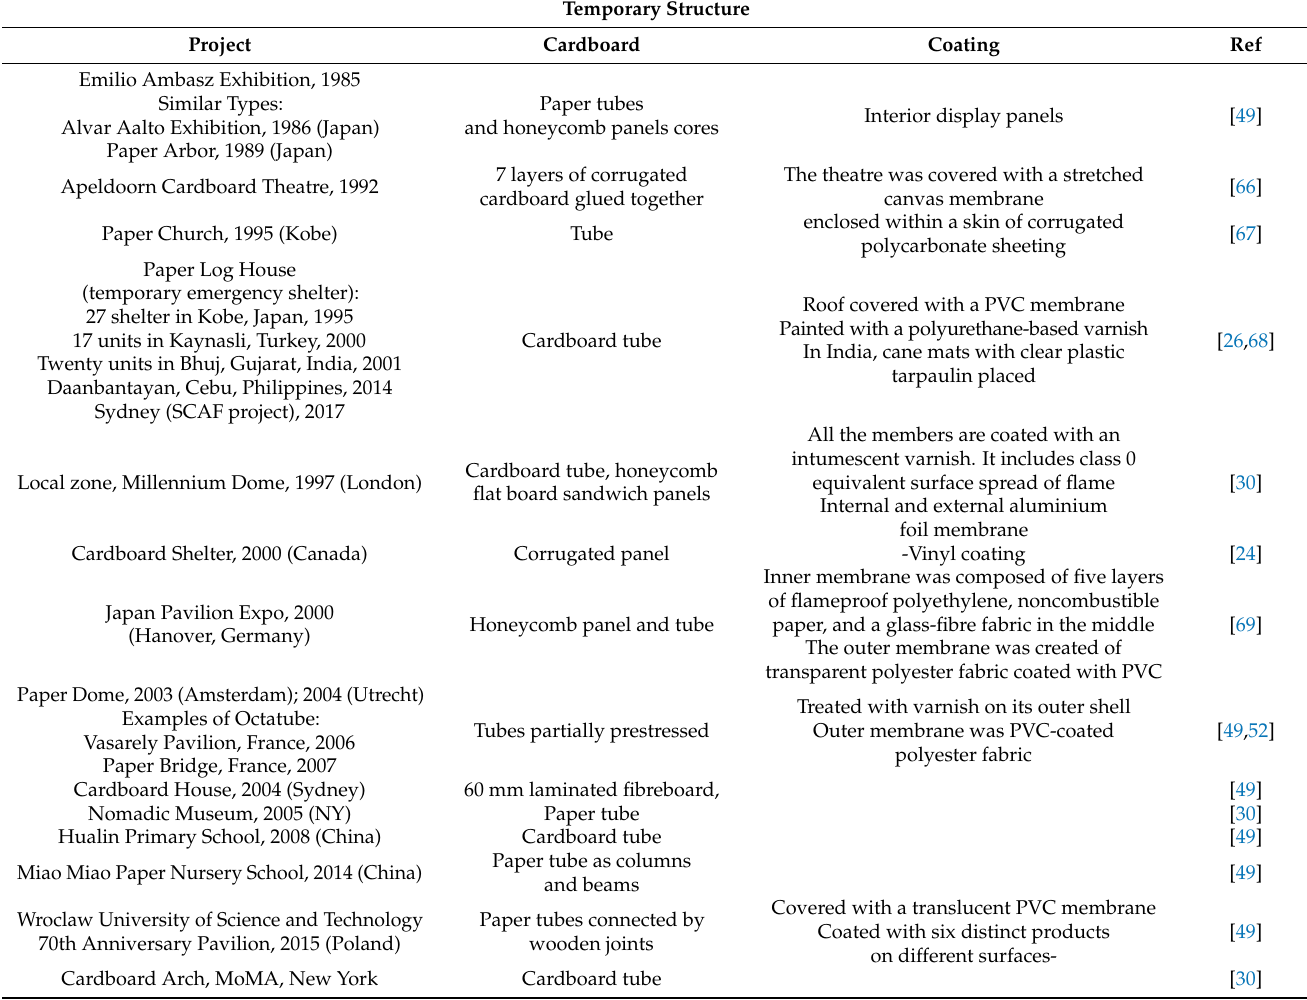
Table 4. Examples of developments of cardboard construction with